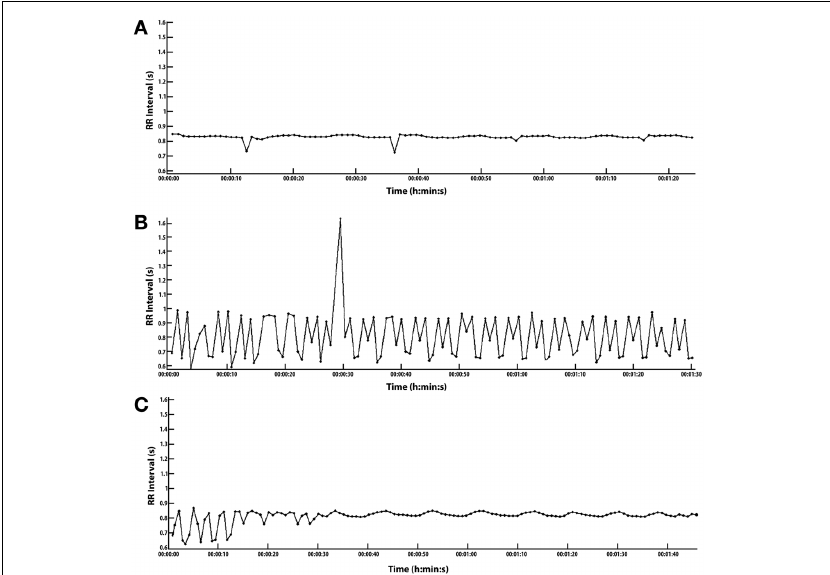
FIGURE 1 | Conversion of arrhythmia with high intensity interval exercise (HIIE). (A–C) ordered from top of page to bottom. Scales are common: RR Interval (s) 0.6–1.6s, Time (h:min:s) is 0